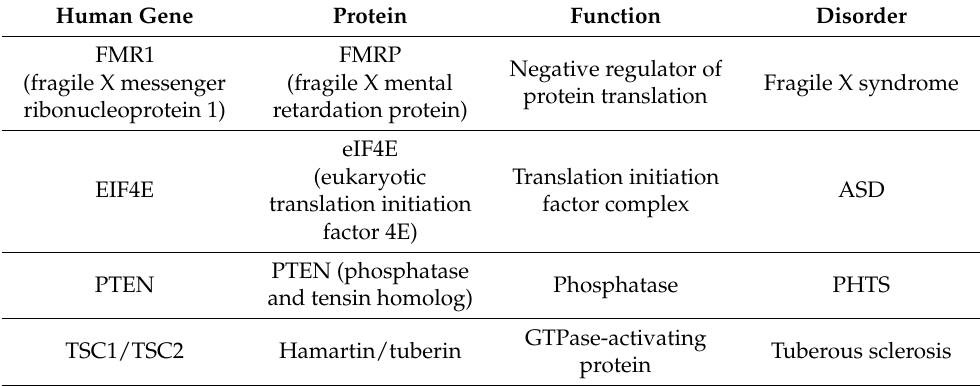
Table 1. Genes of the PI3K-Akt-mTOR pathway involved in ASD. Human Gene